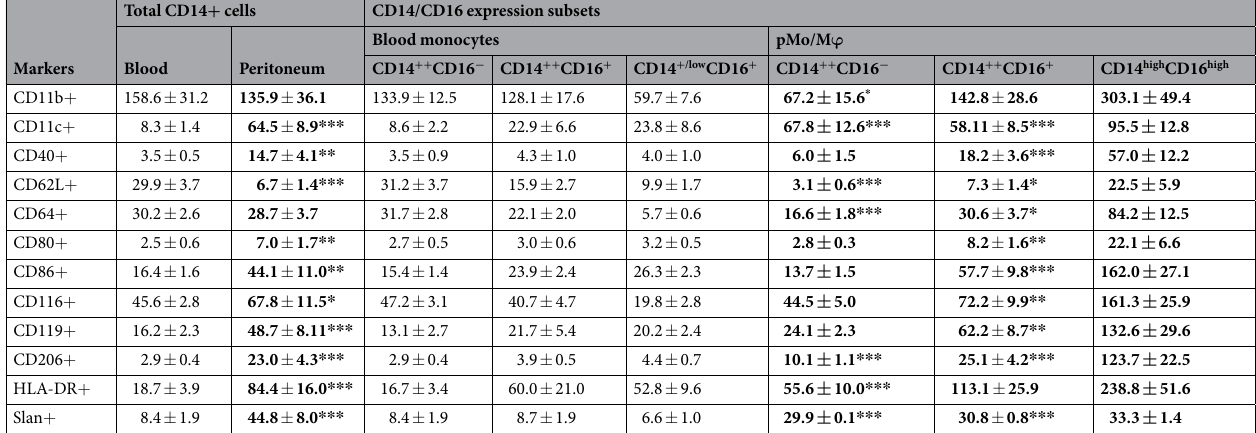
Table 3. Median fluorescence intensity of total pMo/M ϕ and CD14/CD16 subsets compared to blood of healthy humans. Data represent the Mean ± SEM of median fluorescence intensity (MFI) for each membrane marker analyzed. * p < 0.05, ** p < 0.01, and *** p < 0.001, ratios of positive monocyte/macrophages from peritoneum compared to monocytes from blood of healthy